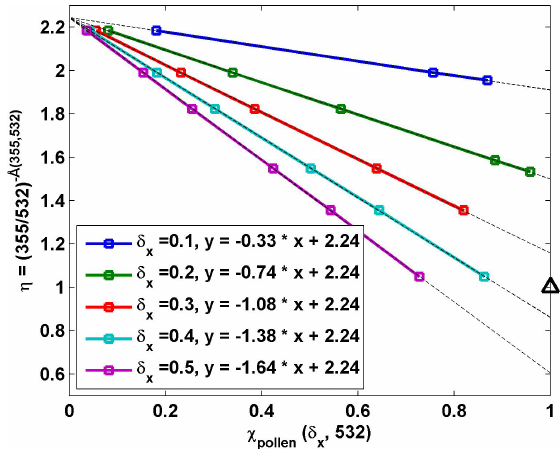
Figure 3. Scatter plots of mean values of η and χ pollen (δ x , 532 ) in the pollen layer in five cases with assumed δ x values. η is a param- eter using the backscatter-related Ångström exponent between 355 and 532nm (Eq. 6), and χ pollen (δ x , 532 ) is the pollen backscatter contribution at 532nm inside the pollen layer under a certain as- sumed pollen depolarization ratio value ( δ x is 0.1, 0.2, 0.3, 0.4, or 0.5). Linear regression lines are drawn by black dotted lines, with the fitting equation shown (Eqs. 5 or 8). The black triangle shows the ideal value: when χ pollen is 1, η should be 1 ( Å = 0).